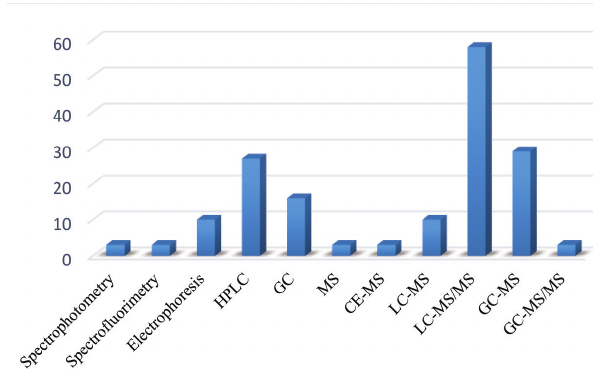
Figure 3: Various bio-analytical methods used for quantification of ADHD drugs.